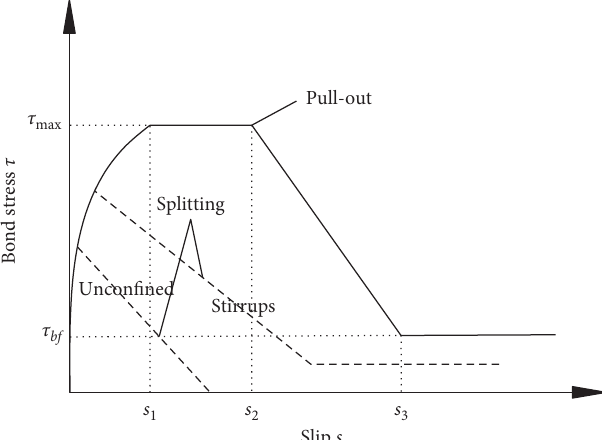
Figure 10: Constitutive models of the steel plate, U-shaped steel strip, support, and bearing plate.